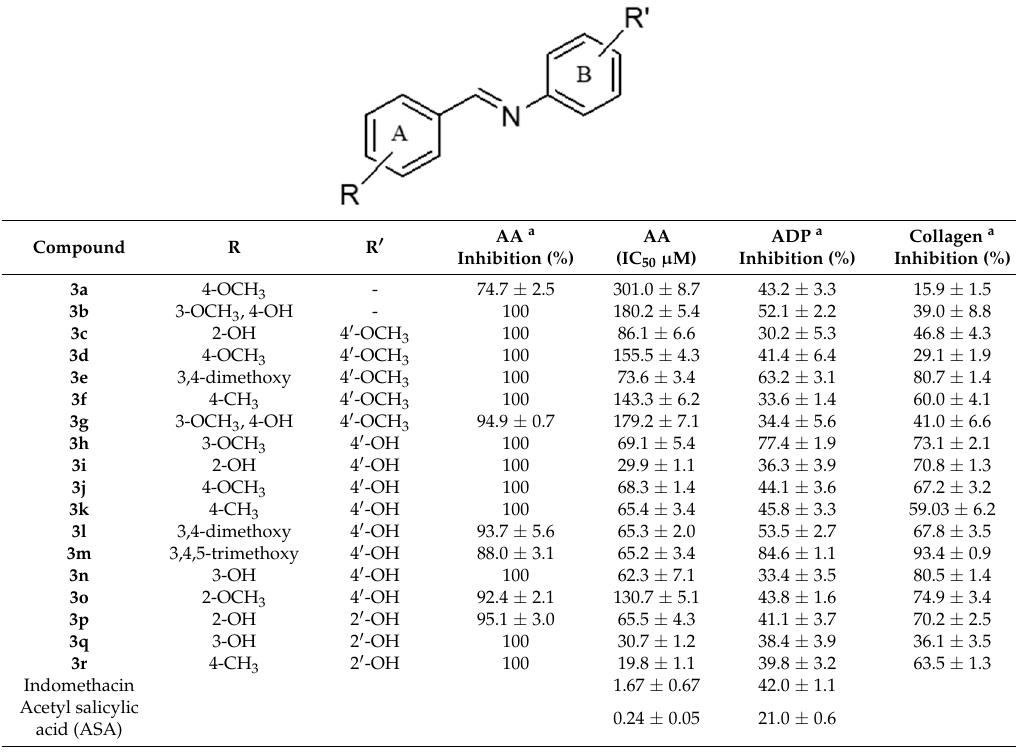
Table 1. Anti-platelet activity of the synthesized derivatives. Adenosine diphosphate (ADP), arachidonic acid (AA), and collagen were used as a platelet aggregation inducer at a final concentration of 5 µM, 1.35 µM, and 2.5 µg·mL − 1 , respectively. The results are expressed as the mean ± standard error of mean (SEM) from three independent experiments.